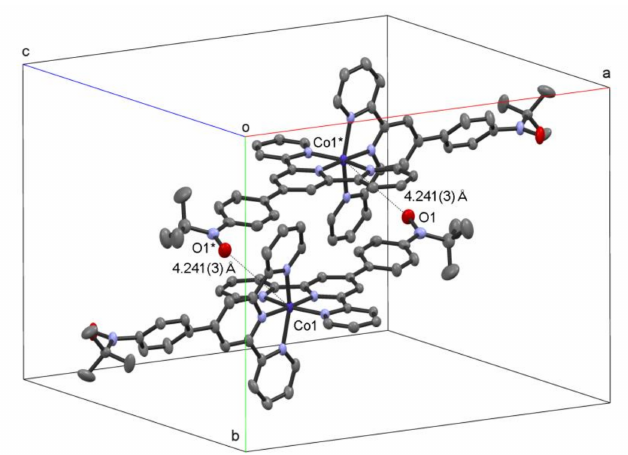
Figure 2. Molecular arrangement in the crystal of [Co(tpyphNO) 2 ](CF 3 SO 3 ) 2 . Only two molecules are shown. Hydrogen atoms and counter anions are omitted for clarity. Symmetry code for * : 1 − x , 1 − y , 1 − z .